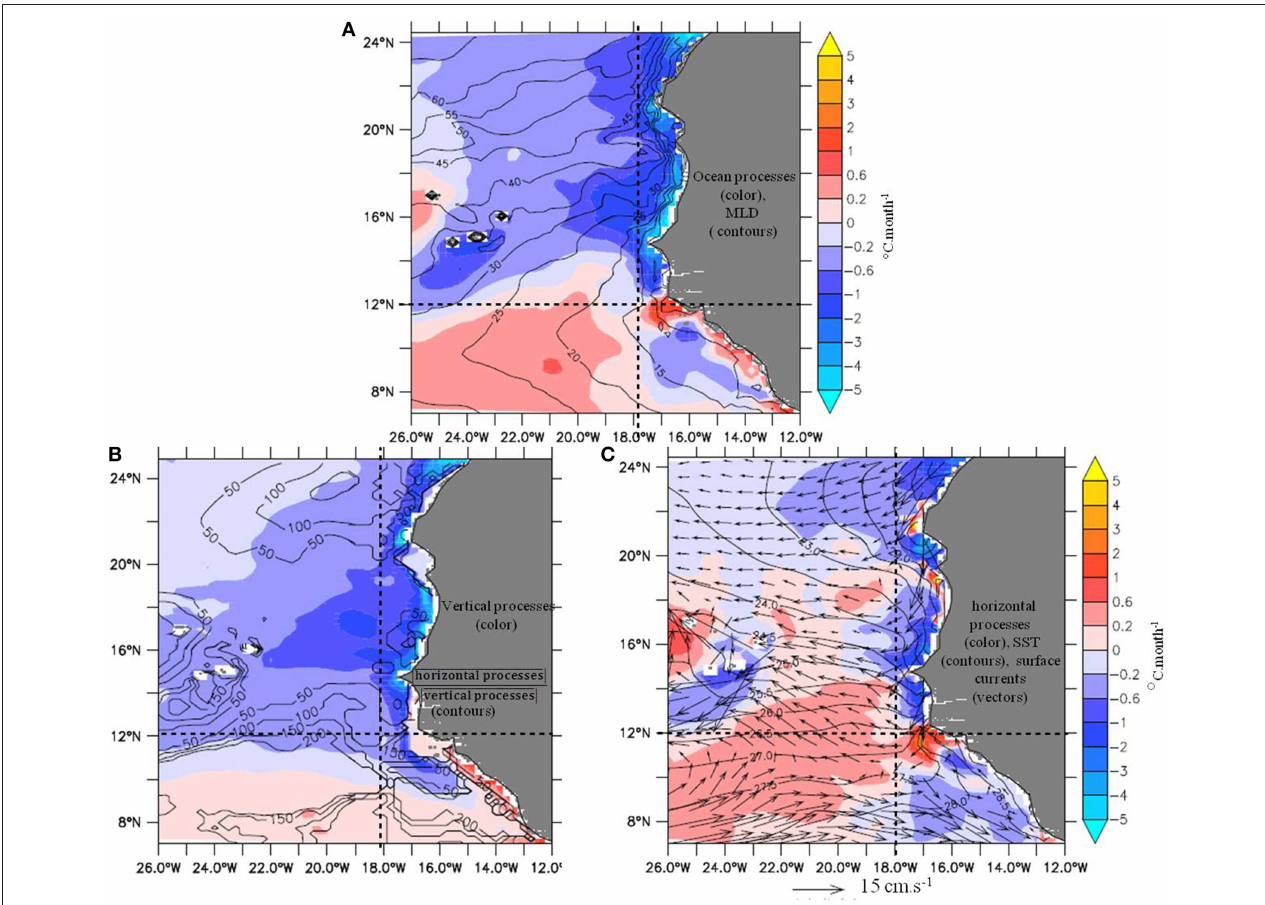
FIGURE 6 | Annual average of the various oceanic processes contributing to the mixed layer heat budget. (A) Total oceanic trend (shading, ◦ C.month − 1 ), and mixed layer depth (MLD, black contours, m), (B) trend associated with vertical processes (sum of vertical advection, vertical diffusion at the base of the mixed layer and RES, shading, ◦ C.month − 1 ) and ratio of horizontal processes over vertical processes (contour every 50, 100, 150, and 200%) and (C) horizontal processes (sum of the horizontal advection and lateral diffusion, shading, ◦ C.month − 1 ), SST (black contour, ◦ C) and surface currents (vectors). Vertical and horizontal dotted lines delimit regimes within the